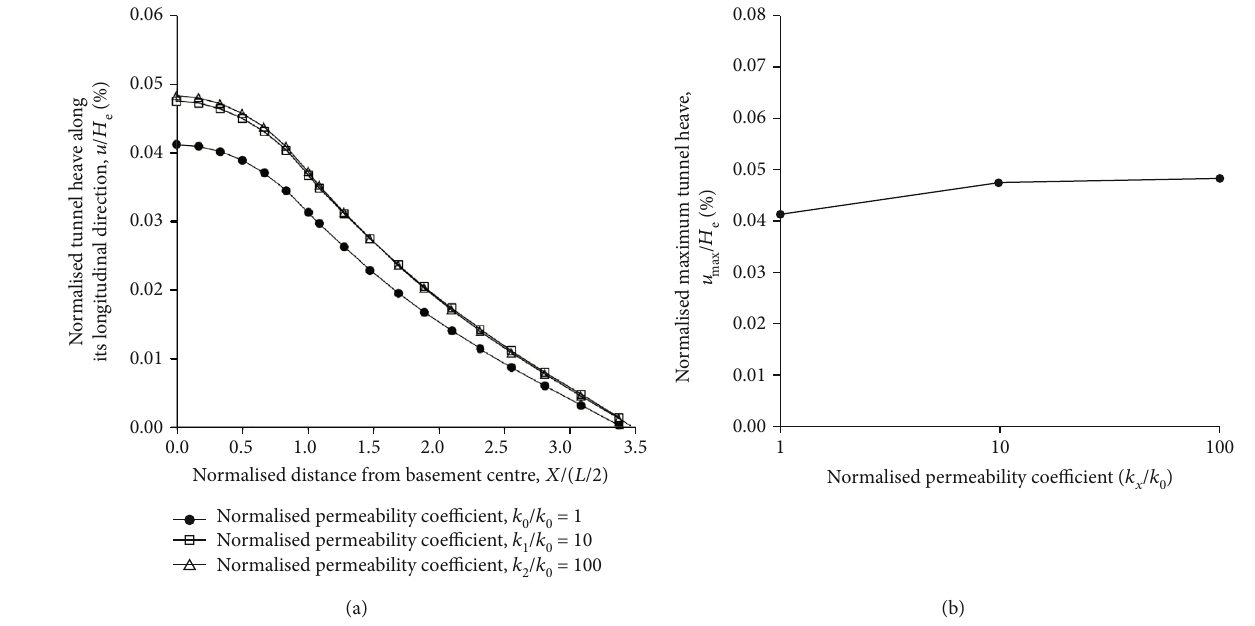
Figure 8: E ff ect of soil permeability on (a) tunnel heave along its axis and (b) maximum tunnel heave in